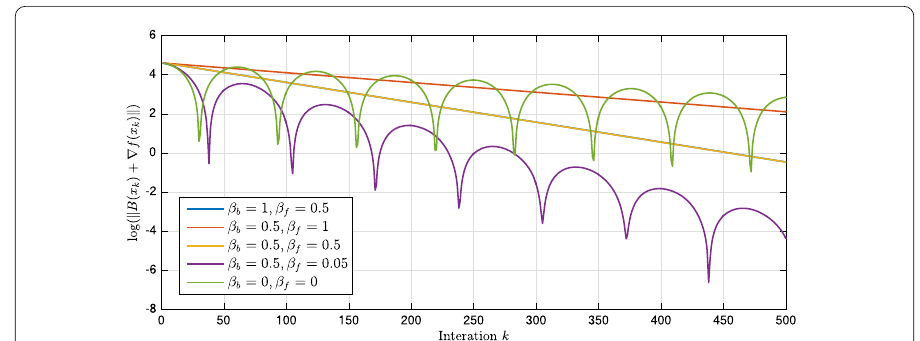
Figure 3 The behavior of (DINAAM) for a high dimension problem